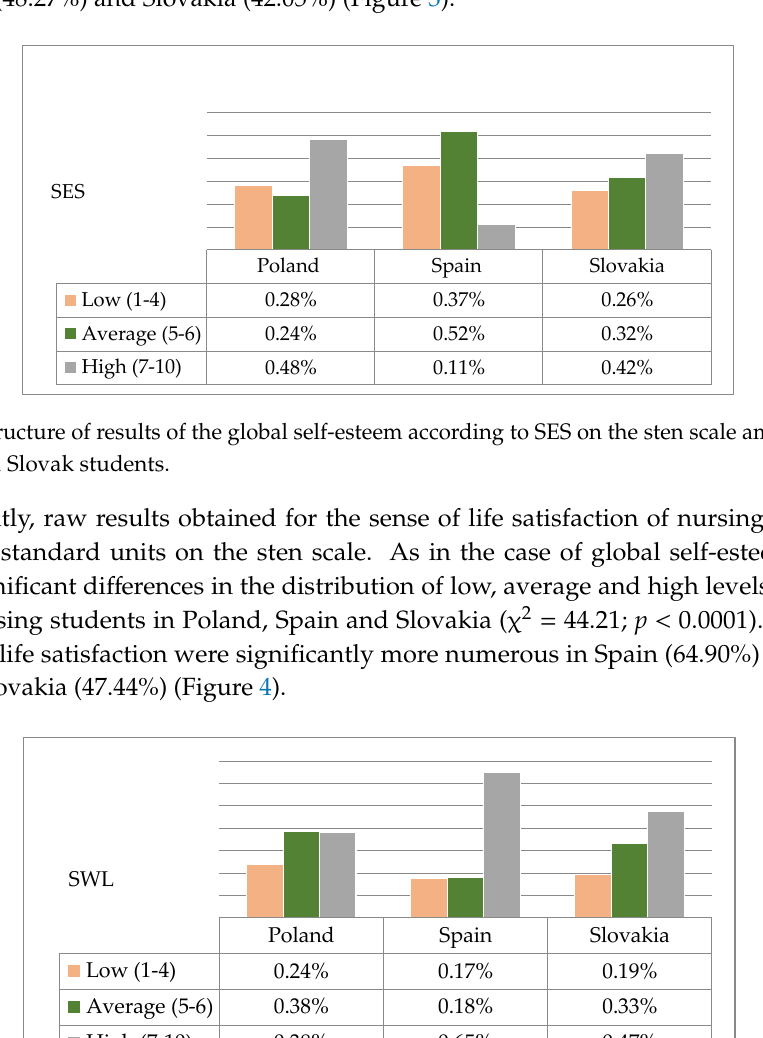
Figure 2. Comparison of average results of life satisfaction according to SWLS among Polish, Spanish and Slovak students.